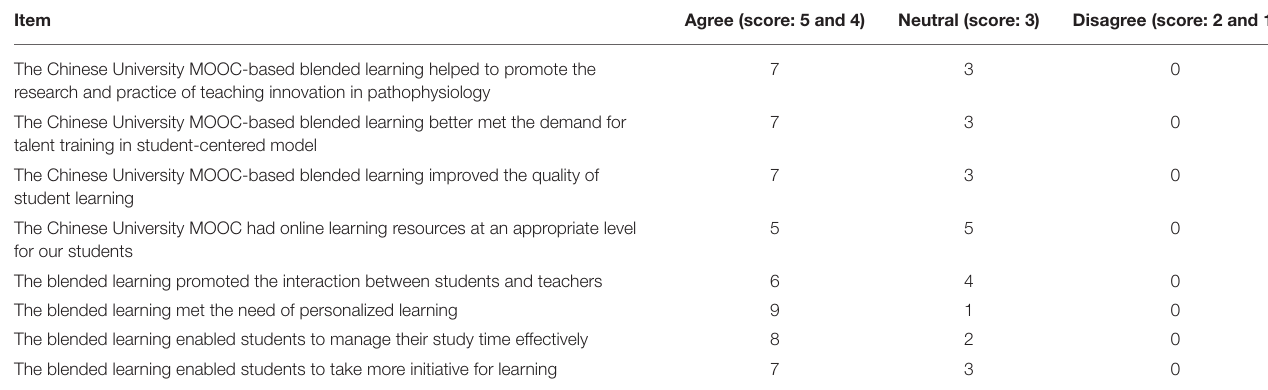
TABLE 3 | Responses from the classroom teachers regarding the blended learning approach. Item Agree (score: 5 and 4) Neutral (score: 3) Disagree (score: 2 and